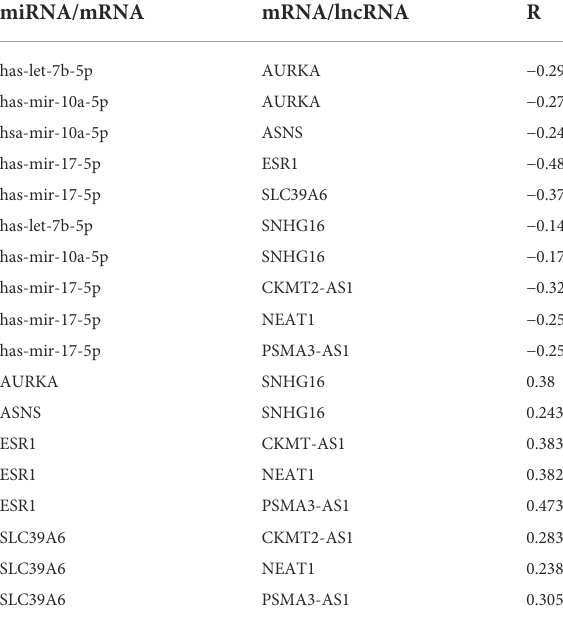
TABLE 1 The correlation between miRNA-mRNA, miRNA-lncRNA and mRNA-lncRNA according to the starBase database. R represents the correlation coef fi cient between genes and all p values are less than